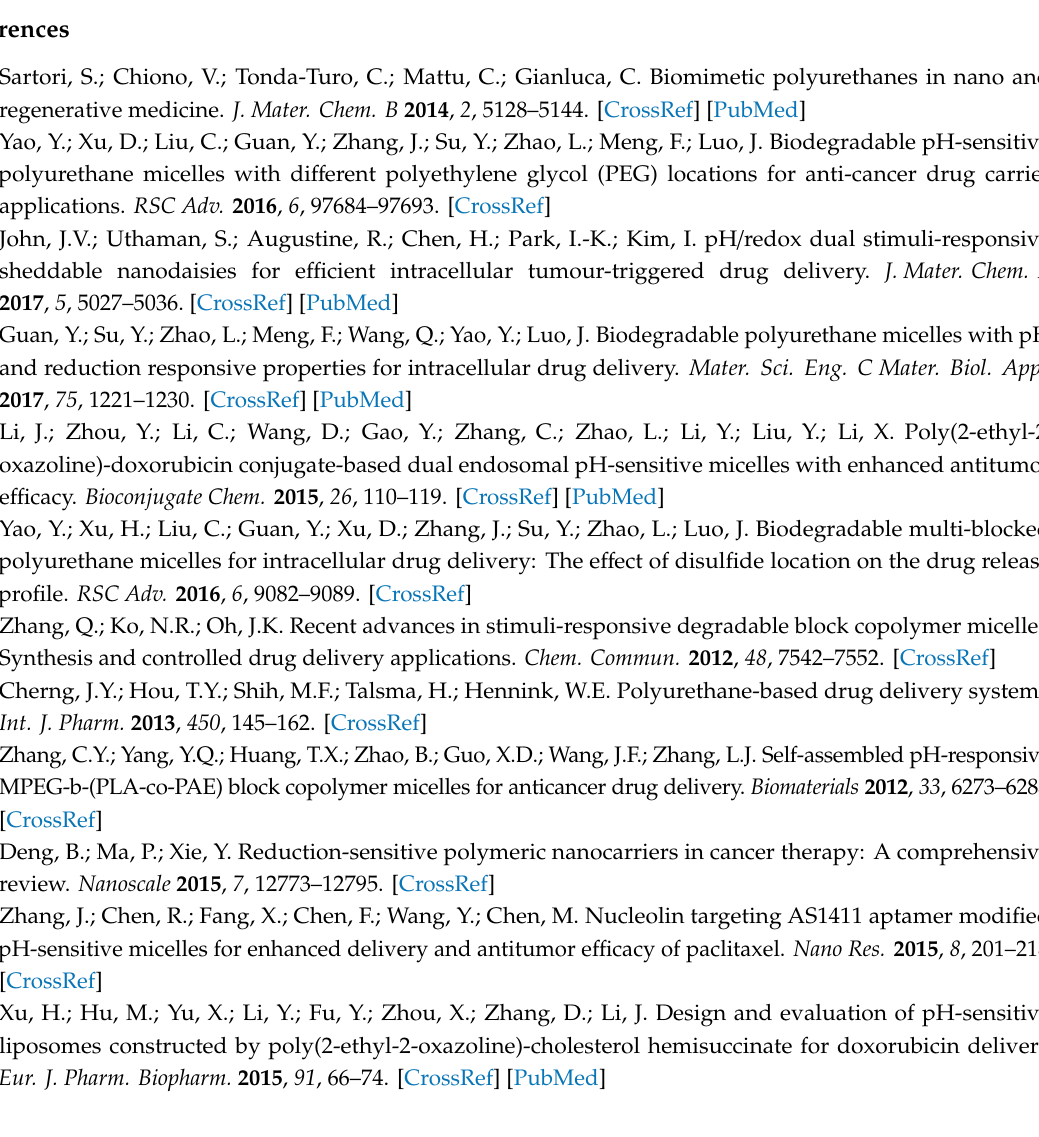
Figure S1: (a) 1 H NMR spectra (400 MHz, CDCl 3 ) of PEtOz-OH. (b) 1 H NMR spectra (400 MHz, CDCl 3 ) of PTMC-SS-PTMC. (c) 1 H NMR spectra (400 MHz, CDCl 3 ) of PEtOz-PU(PTMC)-PEtOz. (d) GPC of PEtOz-PU(PTMCSS)-PEtOz, PEtOz-PU(PTMC)-PEtOz, PEtOz-OHandPTMC-SS-PTMCdiol(Polystyrenestandard, eluant: DMF, temperature: 50 ◦ C, RI detection). Figure S2: (a) Size distribution of PEtOz-PU(PTMCSS)-PEtOz micelles and PEtOz-PU(PTMC)-PEtOz micelles. (b) SEM image of PEtOz-PU(PTMCSS)-PEtOz micelles. (c) SEM image of PEtOz-PU(PTMC)-PEtOz micelles. Figure S3: Fluorescence intensity ratio I 1 / I 3 of pyrene as a function of PEtOz-PU(PTMCSS)-PEtOz micelles and PEtOz-PU(PTMCSS)-PEtOz micelles concentration ((a) PEtOz-PU(PTMCSS)-PEtOz micelles, (b) PEtOz-PU(PTMC)-PEtOz micelles). Table S1: Characteristics of PEtOz-PU(PTMCSS)-PEtOz and PEtOz-PU(PTMC)-PEtOz block copolymers. Table S2: Drug loading content and drug loading e ffi ciency of DOX-loaded micelles of PEtOz-PU(PTMCSS)-PEtOz and